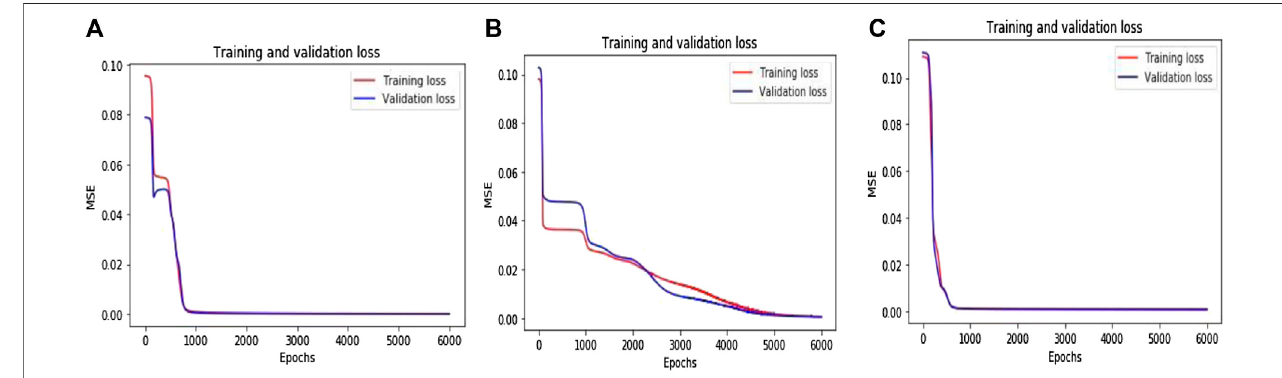
FIGURE 5 | Training and validation loss value over the Epochs (A) 3D LiDAR pcd dataset (B) Sydney Urban 3D Object dataset (C) ISPRS dataset.